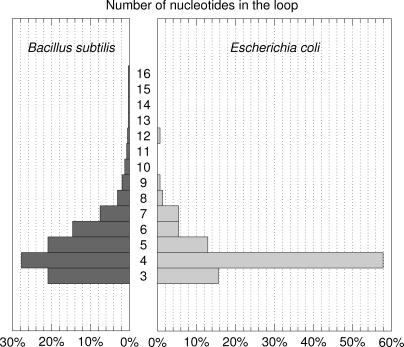
Distribution of the Number of Residues in the Loop of Rho-Independent TerminatorsThe distribution is calculated from 425 transcriptional terminators in B. subtilis and 147 previously collected Rho-independent terminator sequences in E. coli [16].